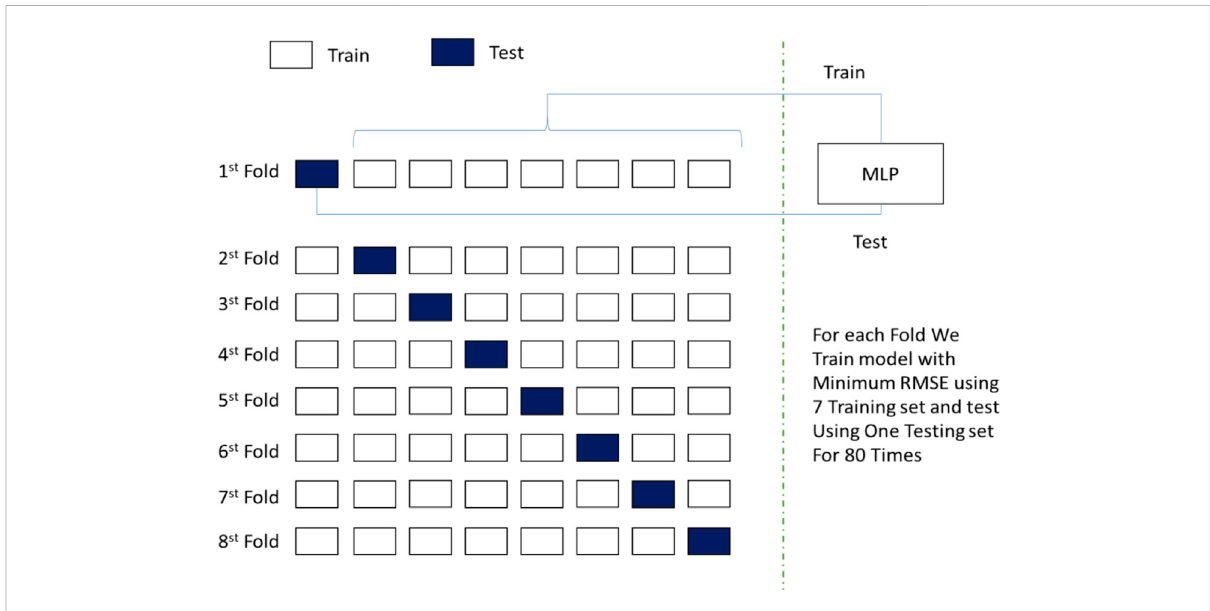
FIGURE 6 Chematic of 8-fold cross validation for FVDC prediction.